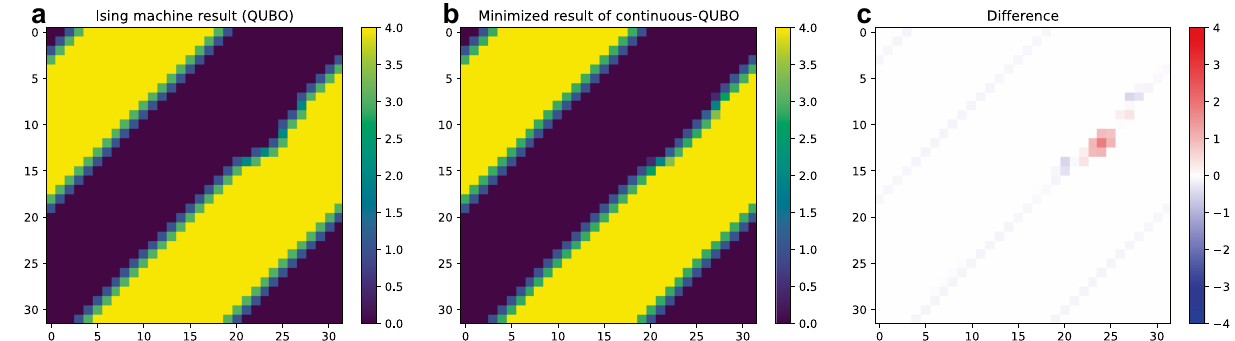
Figure 7. Difference between the result obtained with the Ising machine and the minimized result of continuous-QUBO. ( a ) One of the results obtained with the Ising machine, ( b ) corresponding optimal order parameters of continuous-QUBO, and ( c ) difference between the two